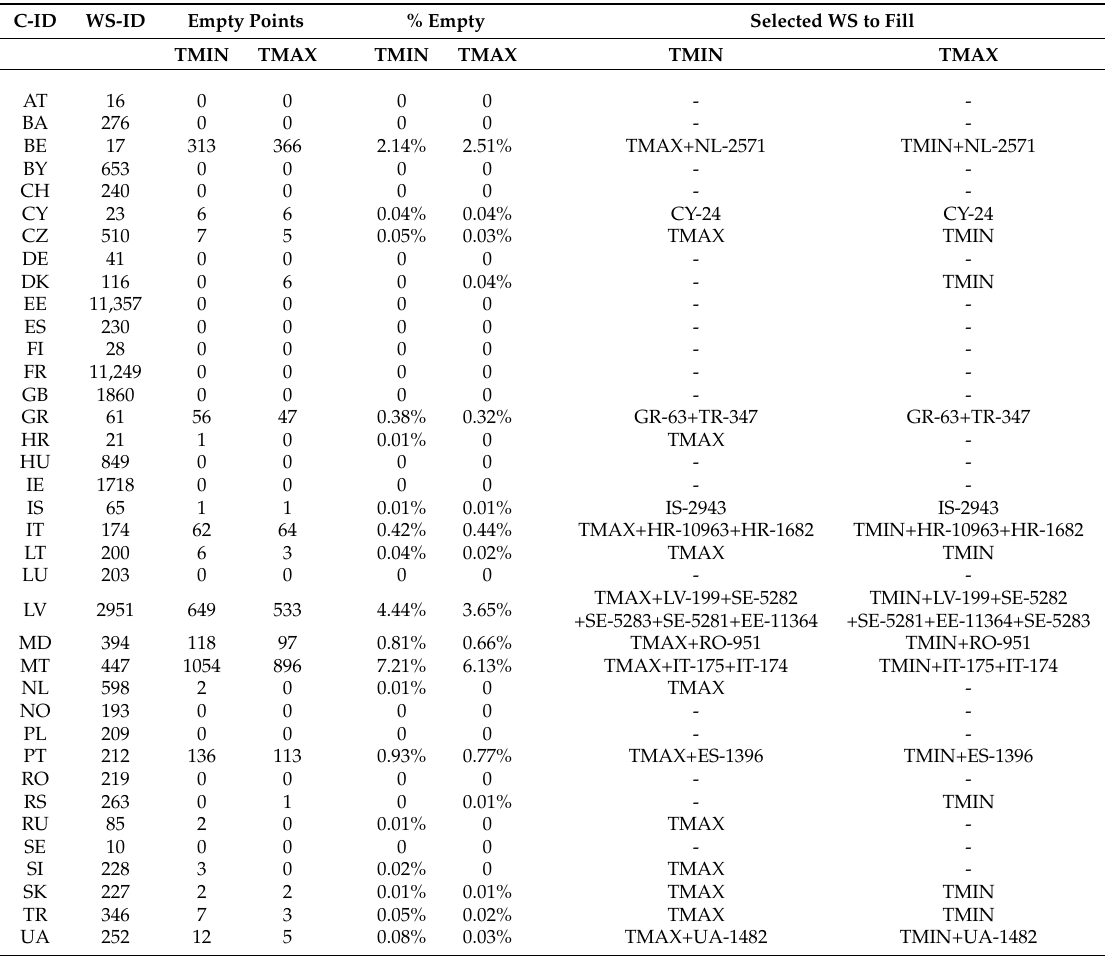
Table A3. Detail of the missing points of the reference WS of each country.The first two columns show the Country ID (C-ID) and Station ID (WS-ID). The last two columns show the neighbouring WS than have been used to fill all the empty points of each time